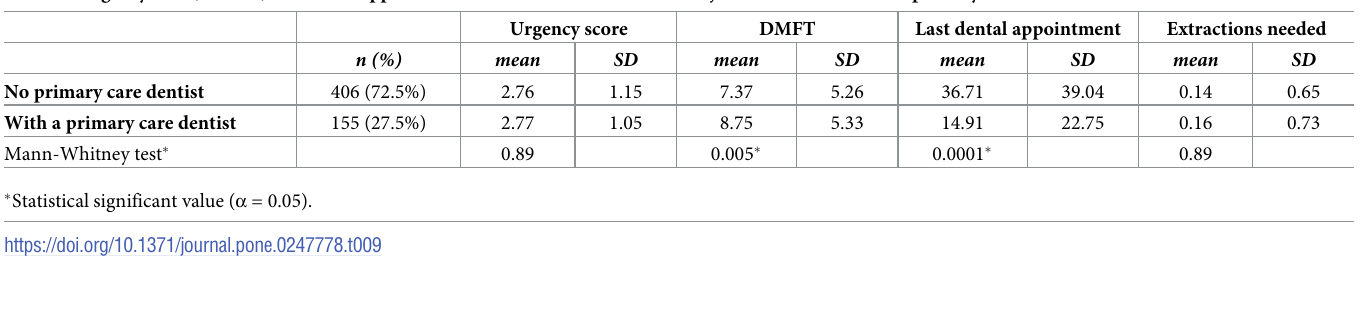
Table 9. Urgency score, DMFT, last dental appointment and extraction needed in subjects with and without a primary care